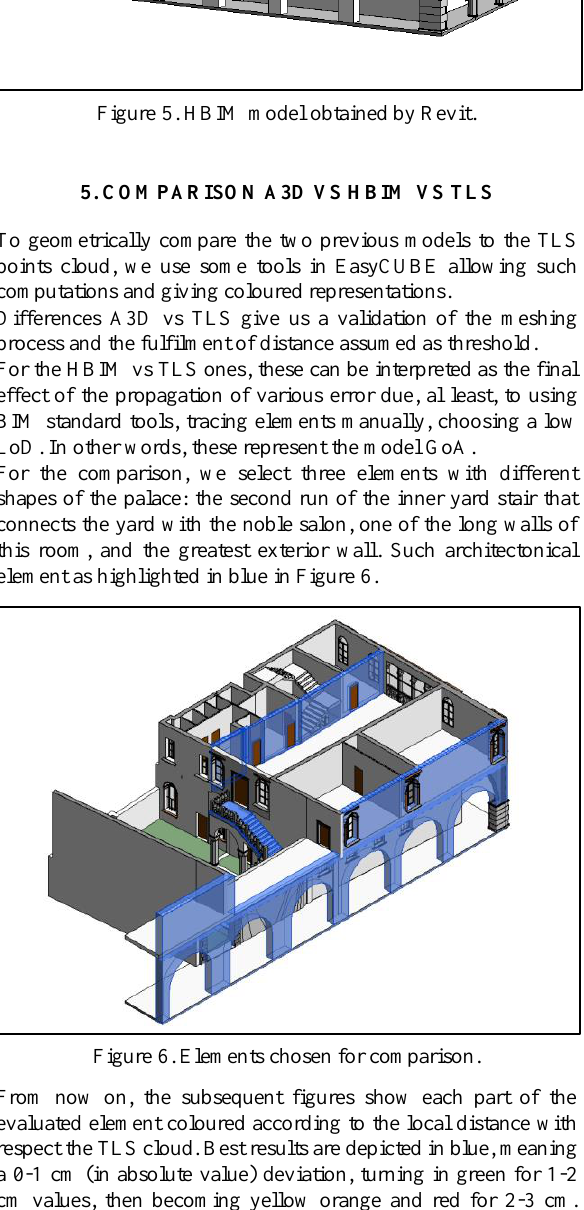
5. COMPARISON A3D VS HBIM VS TLS